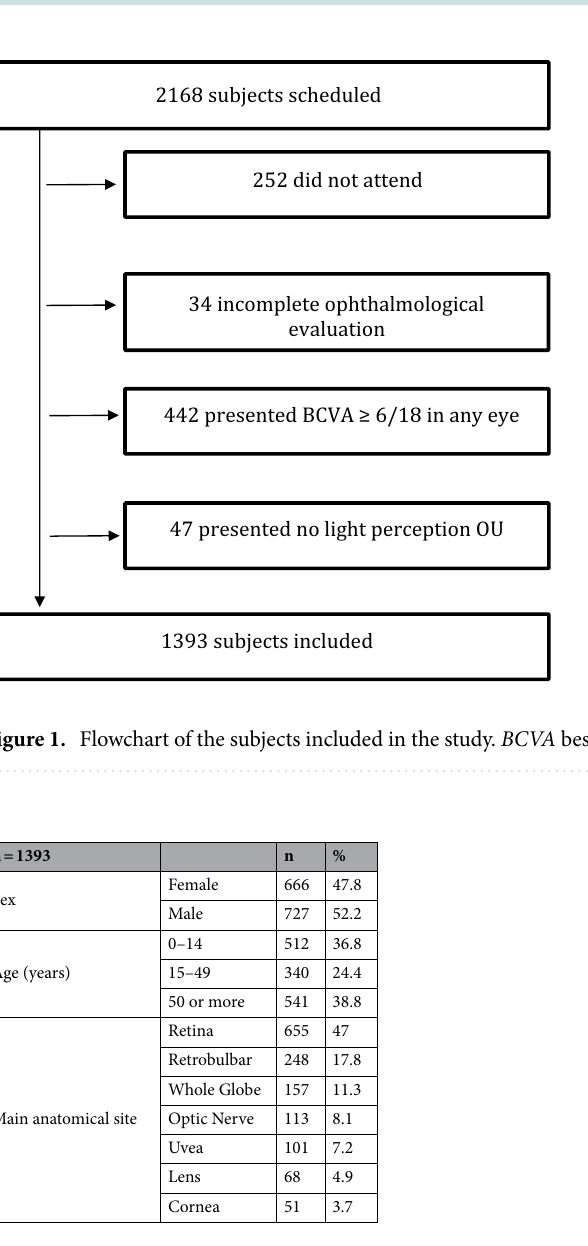
Table 1. Demographic and clinical characteristics of the subjects studied (n = 1393). n number of subjects.